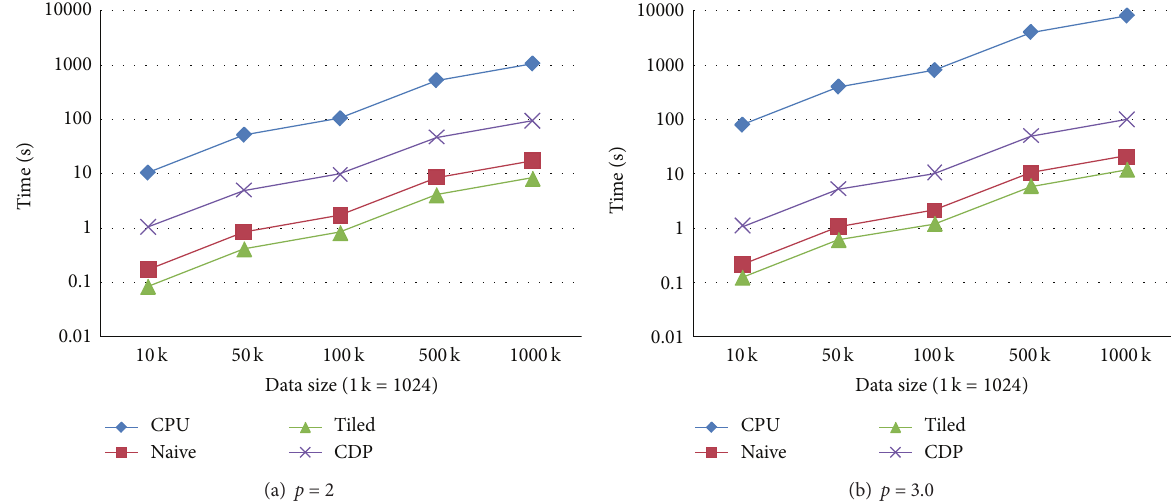
Figure 6: Execution times in the test case when the number of prediction points is fixed, and the number of data points differs. (a) The form in which the power parameter is set to 2. (b) The form in which the power parameter is set to